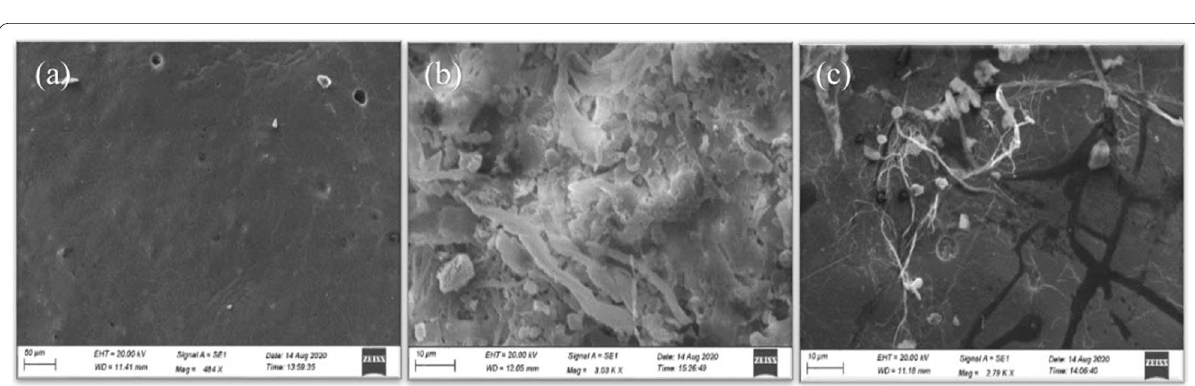
Fig. 6 SEM images of chrome tanned leather a control, b fungi infected, c fungi infected with UV exposure sample after 30